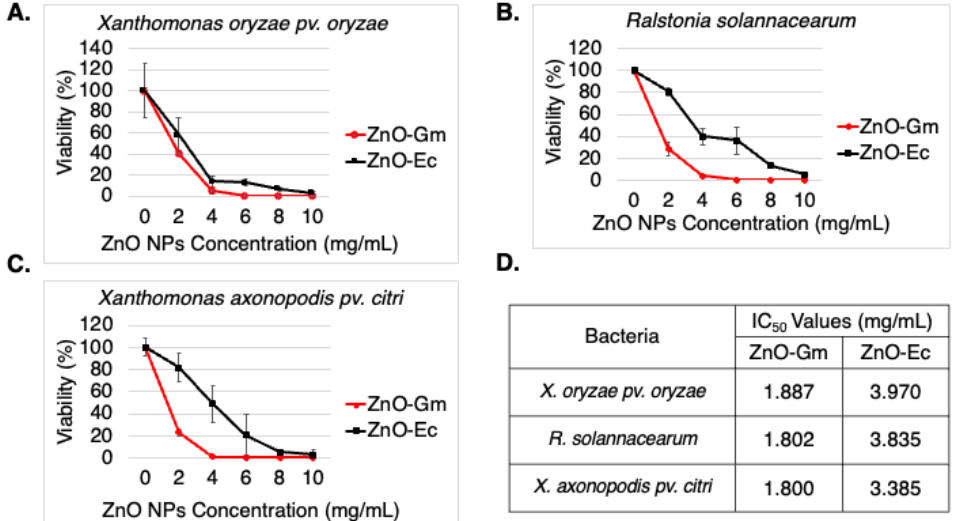
Figure 6. Synthesized ZnO NPs possessed antibacterial activity ( A ) Viability (%) of Xanthomonas oryzae pv. oryzae (rice bacterial blight pathogen), ( B ) Viability (%) of Xanthomonas axonopodis pv. citri (citrus canker disease), ( C ) Viability (%) of Ralstonia solanacearum (bacterial wilt disease), ( D ) IC 50 values of ZnO-Gm and ZnO-Gc against tested bacteria in the study. The data are represented in quadruplicate of mean ± SD from at least three independent experiments.